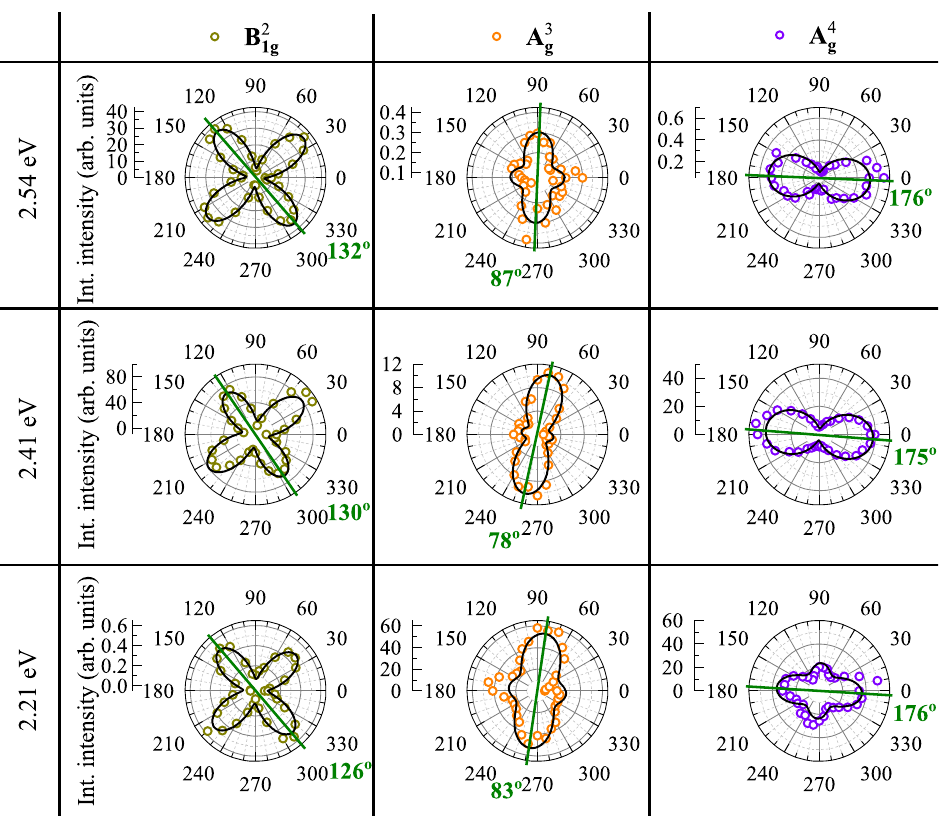
Figure 6. Polar plots of the integrated intensities of the phonon modes B 2